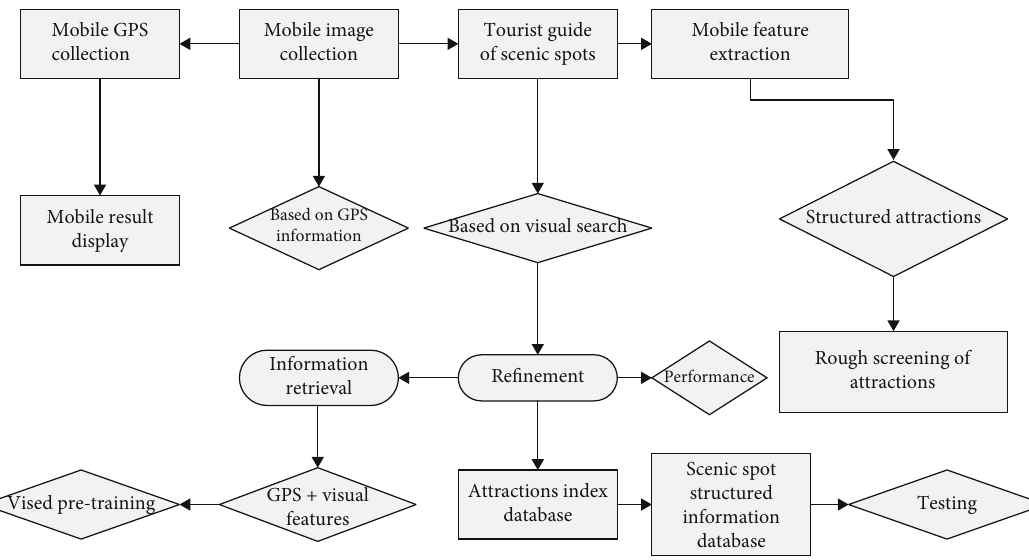
Figure 3: Overall framework of the tour guide